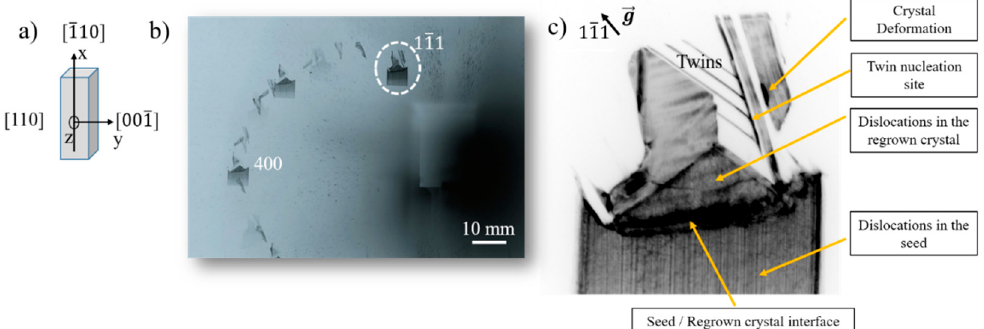
Figure 3. X-ray diffraction imaging (topography) during solidification (applied temperature gradient: 30 K/cm and cooling rate of -1 K/min applied on both heaters) from a FZ seed. ( a ) Crystallographic orientationoftheseed. ( b )Lauepatternshowingthedi ff ractionspotsrecordedattheendofsolidification in the field of view. ( c ) Topograph of the 111 di ff raction spot during solidification.